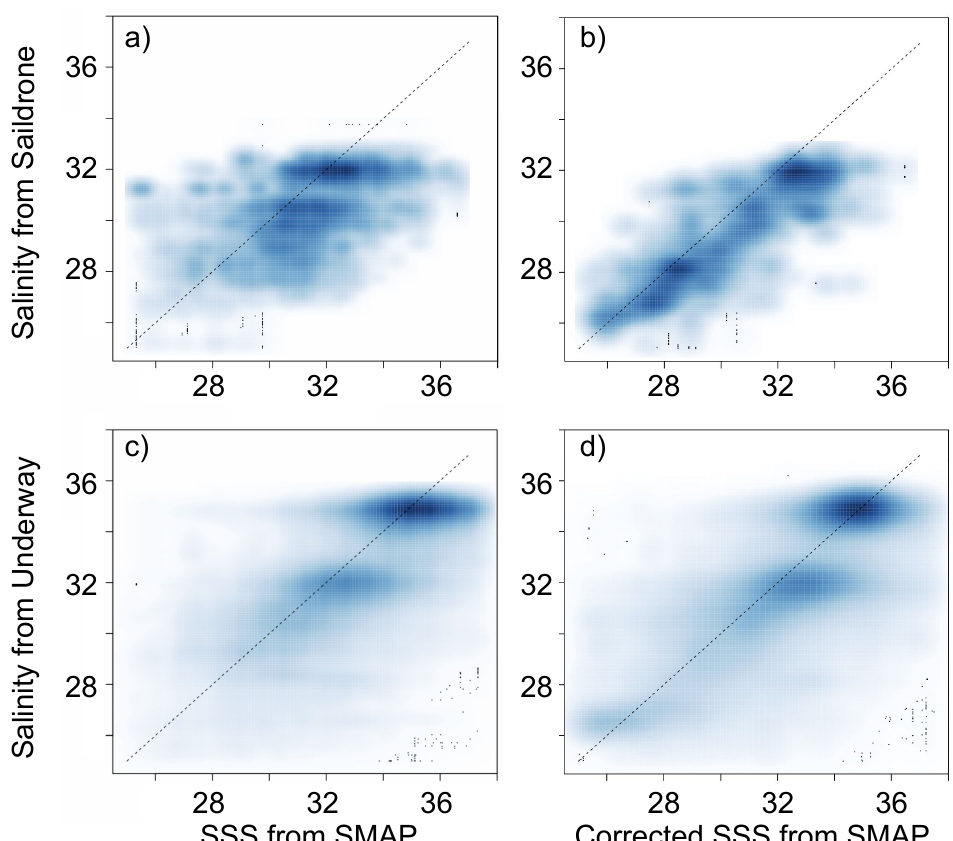
Figure 7. Comparison of in-situ and Level-2 SMAP SSS observations (sampled within 50 km and 3.5 days of in-situ bulk surface salinity observations) for the period of April 2015 to December 2019 (abscissa = SMAP, ordinate = in-situ): Level-2 SMAP (panels a , c ) and skin-effect and bias-corrected Level-2 SMAP (panels b , d ) data; Saildrone (panels a , b ) and Underway (panels c , d ). The darker the shade of blue, the greater the number of points in the scatterplots; outliers are shown with single black